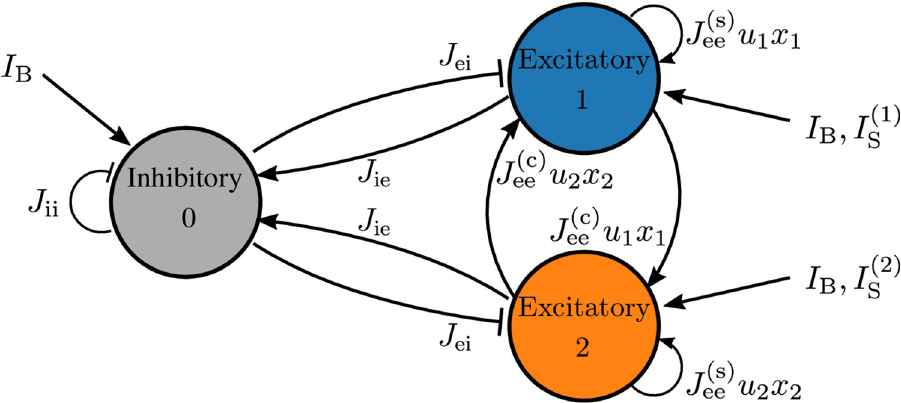
Fig 2. Two-item architecture. The reported network is composed of two identical and mutually coupled excitatory populations and an inhibitory one: this architecture can at most store two WM items, one for each excitatory